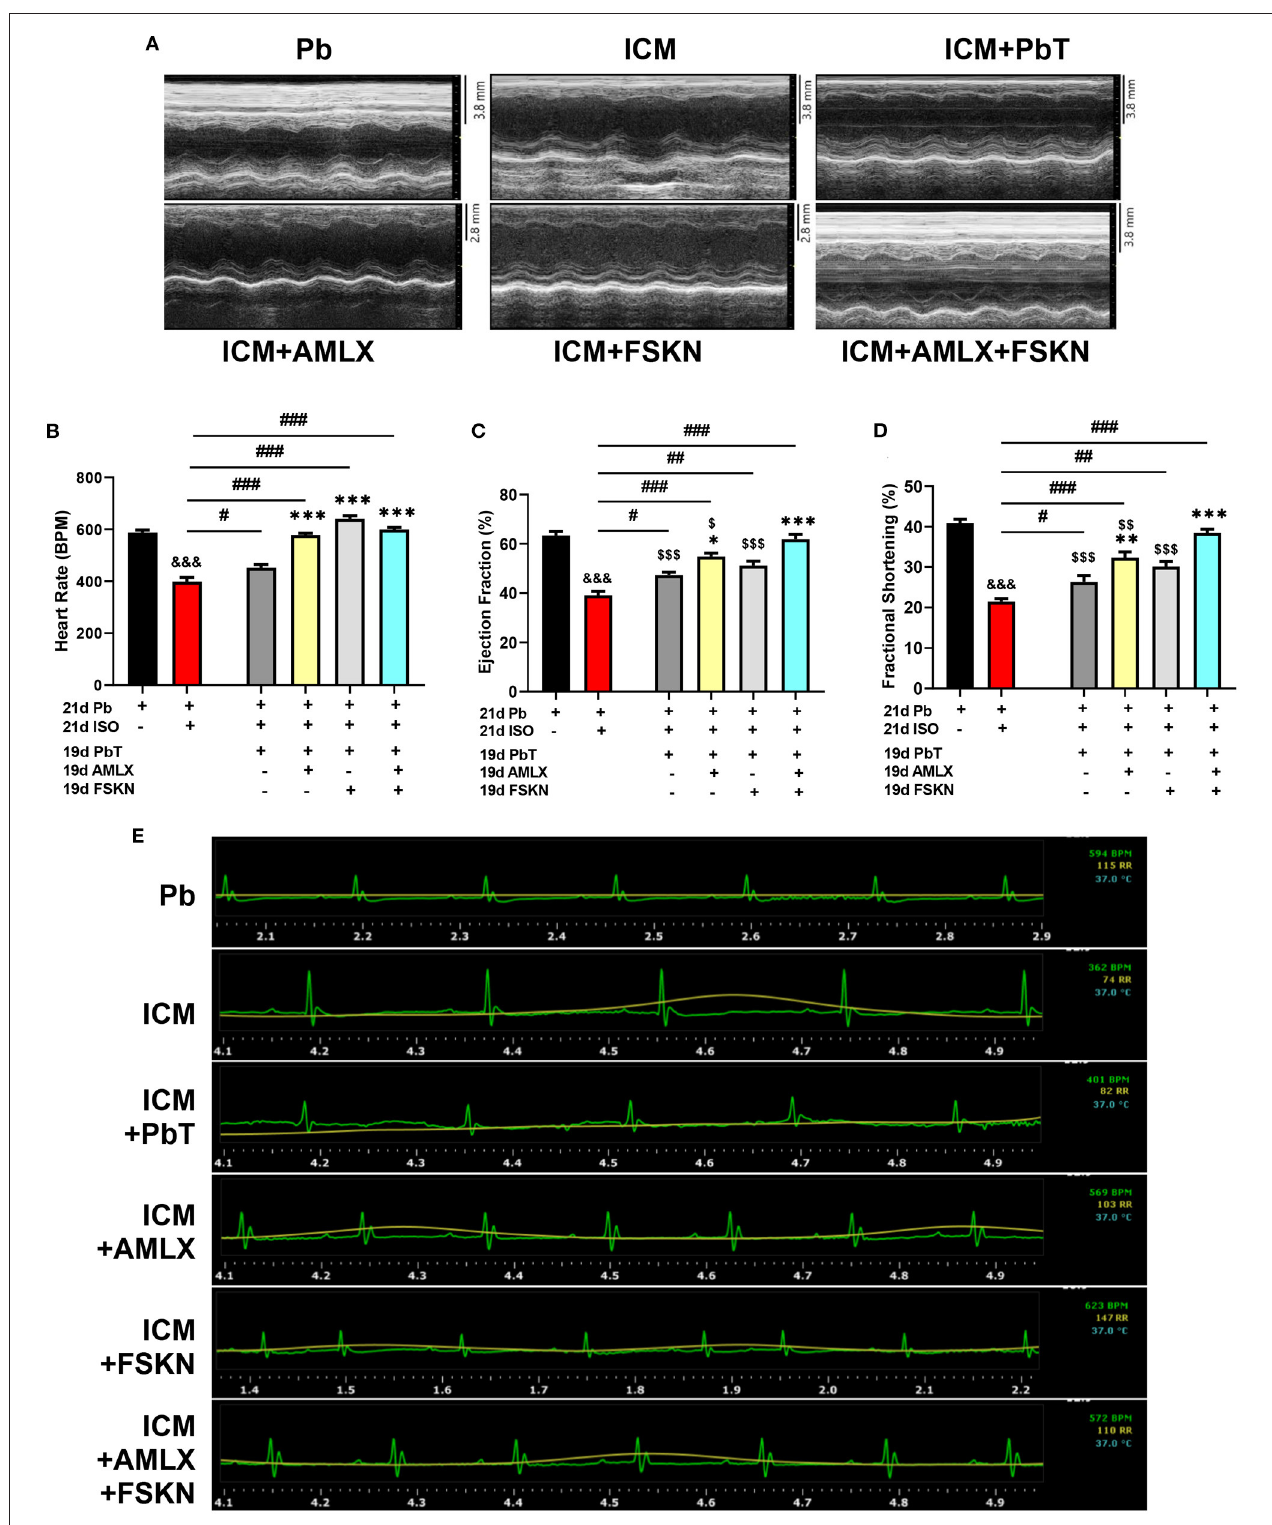
FIGURE 2 | Amlexanox and Forskolin ameliorates isoproterenol-induced LVSD. (A) Representative echocardiogram imaging obtained in short-axis view M-mode from all the experimental groups. (B) Graphical presentation of heart rates assessments from electrocardiography. (C,D) Graphical presentation of cardiac systolic